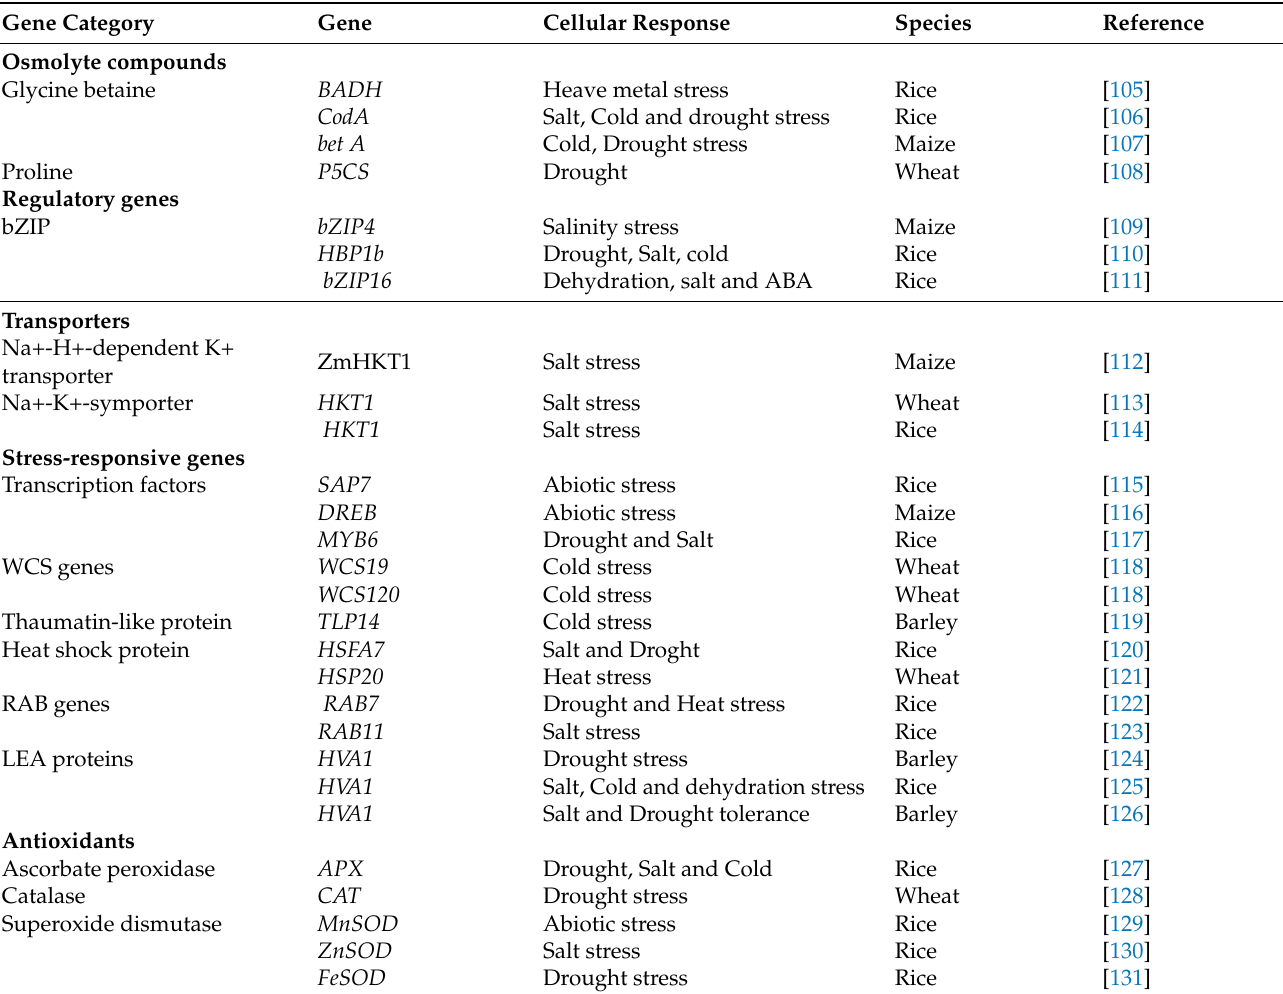
Table 3. Genes encoding enzymes/proteins associated with abiotic stress response in